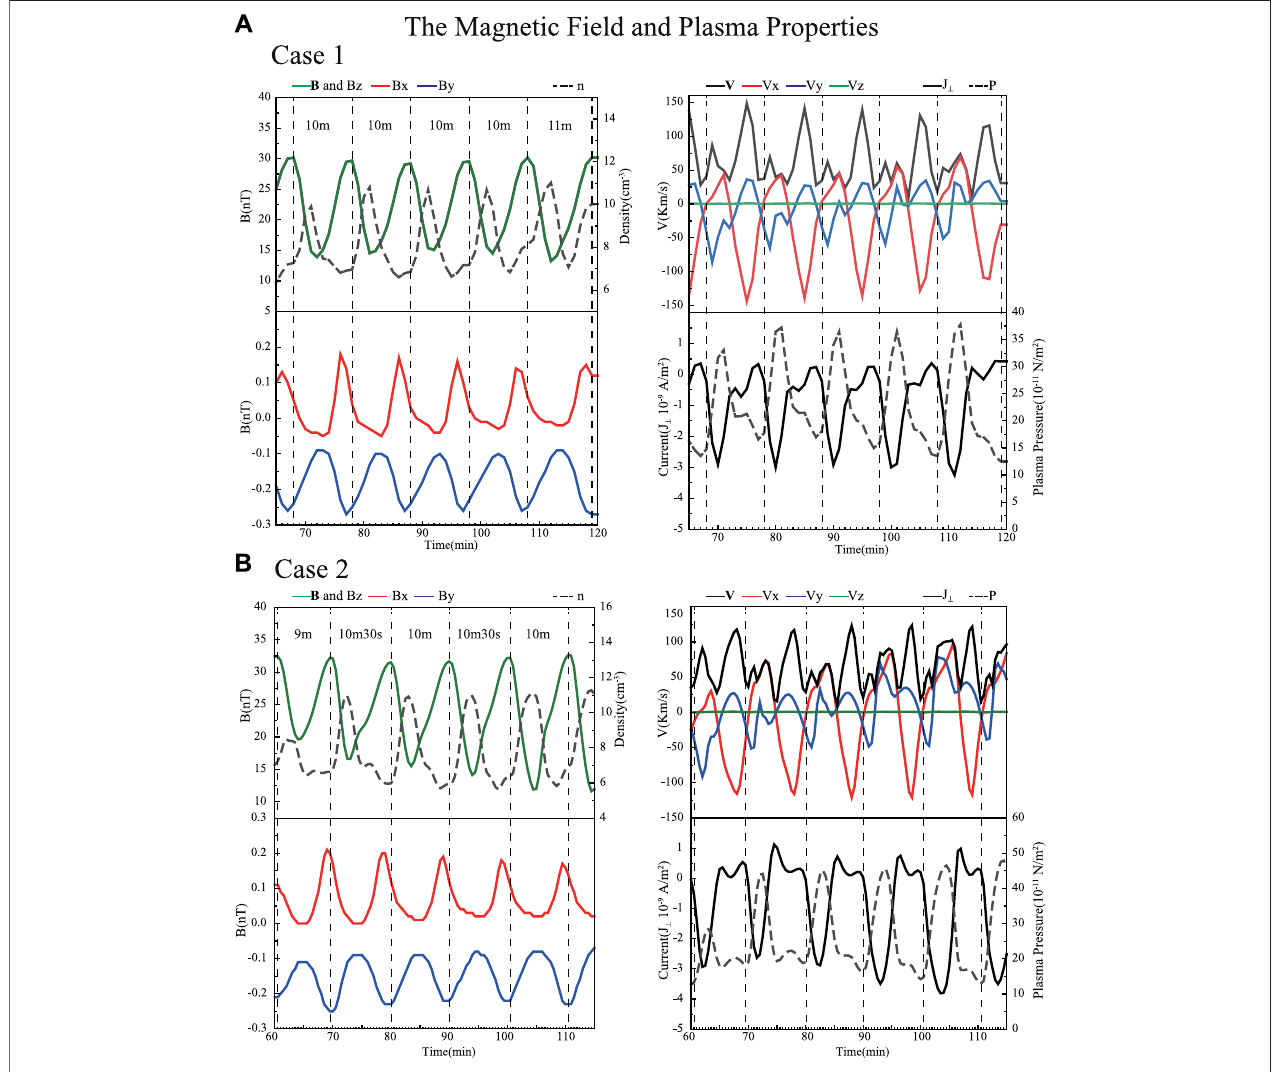
FIGURE 5 | The time evolution of the magnetic fi eld and plasma density (left) and the plasma fl ow vector, current density and plasma pressure (right) from 65 to 120 mininCase1 (A) andfrom60to115 mininCase2 (B) .Thedatawereselectedatthe X (cid:1) 6.9 R E , Y (cid:1) 9.9 R E and Z (cid:1) 0 R E inCase1and X (cid:1) 8.9 R E , Y (cid:1) 8.1 R E and Z (cid:1) 0 R E in Case 2 across the vortex A in Figure 3